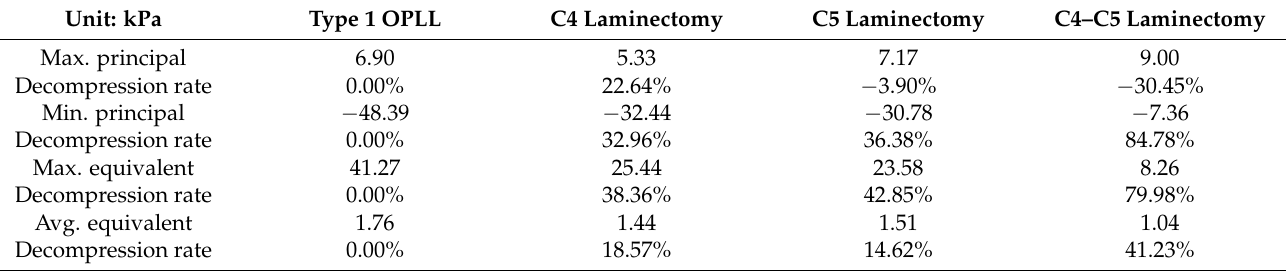
Figure 11. Extension laminectomy simulation: ( a ) maximum and minimum principal stresses (kPa); and ( b ) maximum and average equivalent stresses (kPa). Table 10. Extension laminectomy simulation spinal cord stresses: type 1 OPLL.